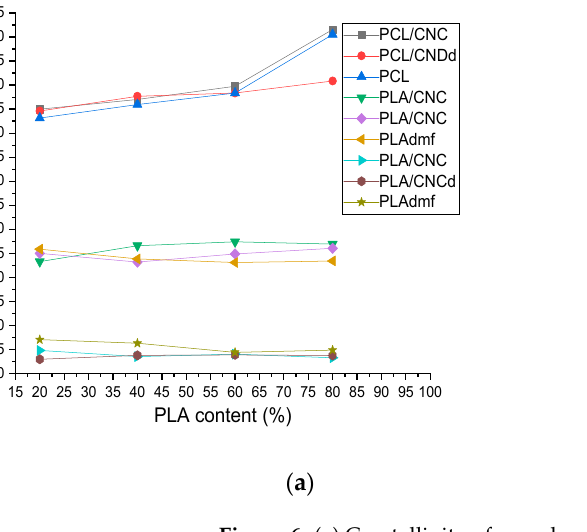
Figure 6. ( a ) Crystallinity of samples prepared using CNC and CNCd masterbatch in PLA, and DMF-treated PLA (PLAdmf); ( b ) Crystallinity of samples prepared using CNC and CNCd masterbatch in PCL, and DMF-treated PCL (PCLdmf);The three sets of plots (from top to bottom) are the crystallinity of PCL, cold crystallization of PLA after heating, and initial crystallinity of PLA, respectively. Each set contains PLA/CNC masterbatch, PLA/CNCd masterbatch, and NF-free blend (PLAdmf).